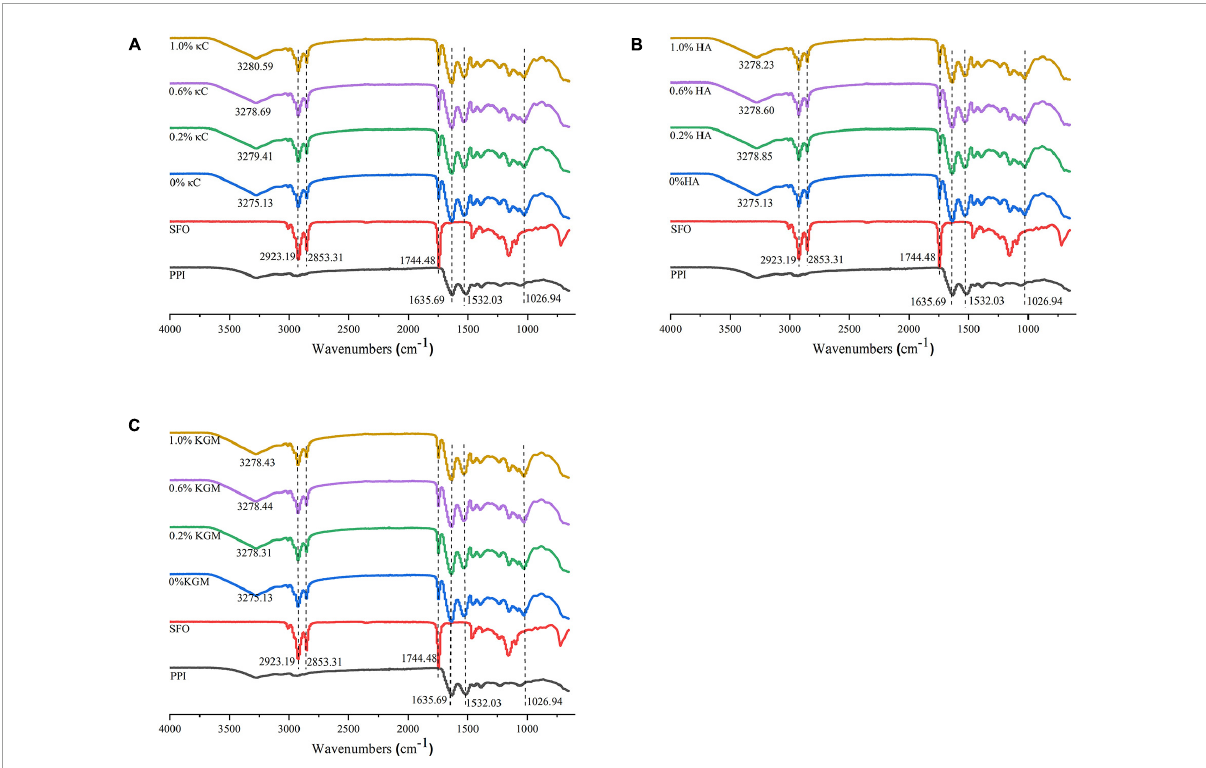
FIGURE9 Infrared spectra of emulsion gels containing different polysaccharides: (A) κ C, (B) HA, and (C) KGM. PPI, pea protein isolate; κ C, κ -carrageenan; HA, high-acyl gellan; KGM, konjac glucomannanon; SFO, Sunflower seed oil.